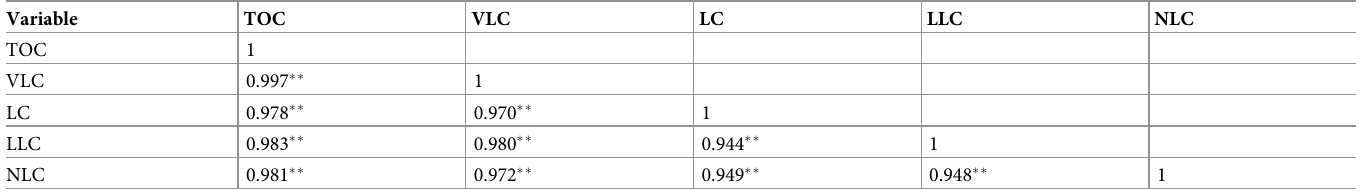
Table 5. Correlation coefficient (Pearson’s) between different organic carbon pools in soils (0–45 cm soil depth) under different land use types in Mizoram. Variable